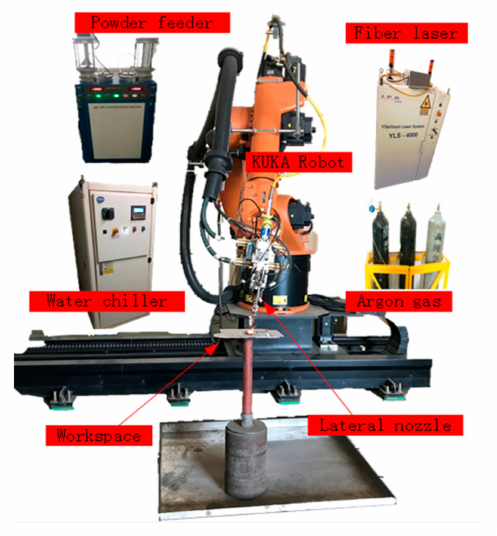
Figure 5. The equipment used for laser cladding.